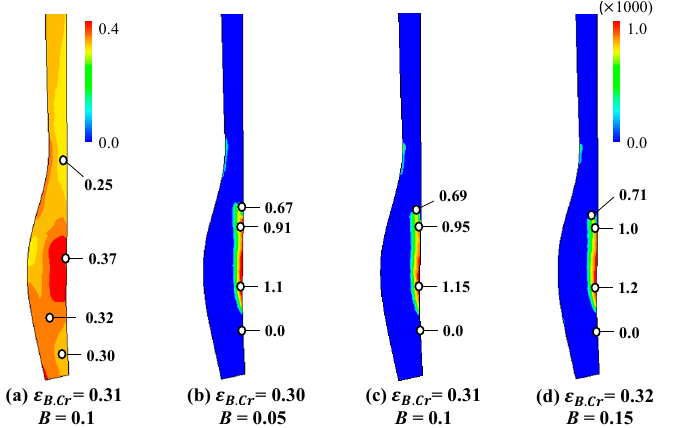
Figure 13. Degree of PDIE (plastic deformation-induced embrittlement) and prediction of brittle fracture. ( a ) Degree of PDIE, ( b – d ) brittle fracture maps.